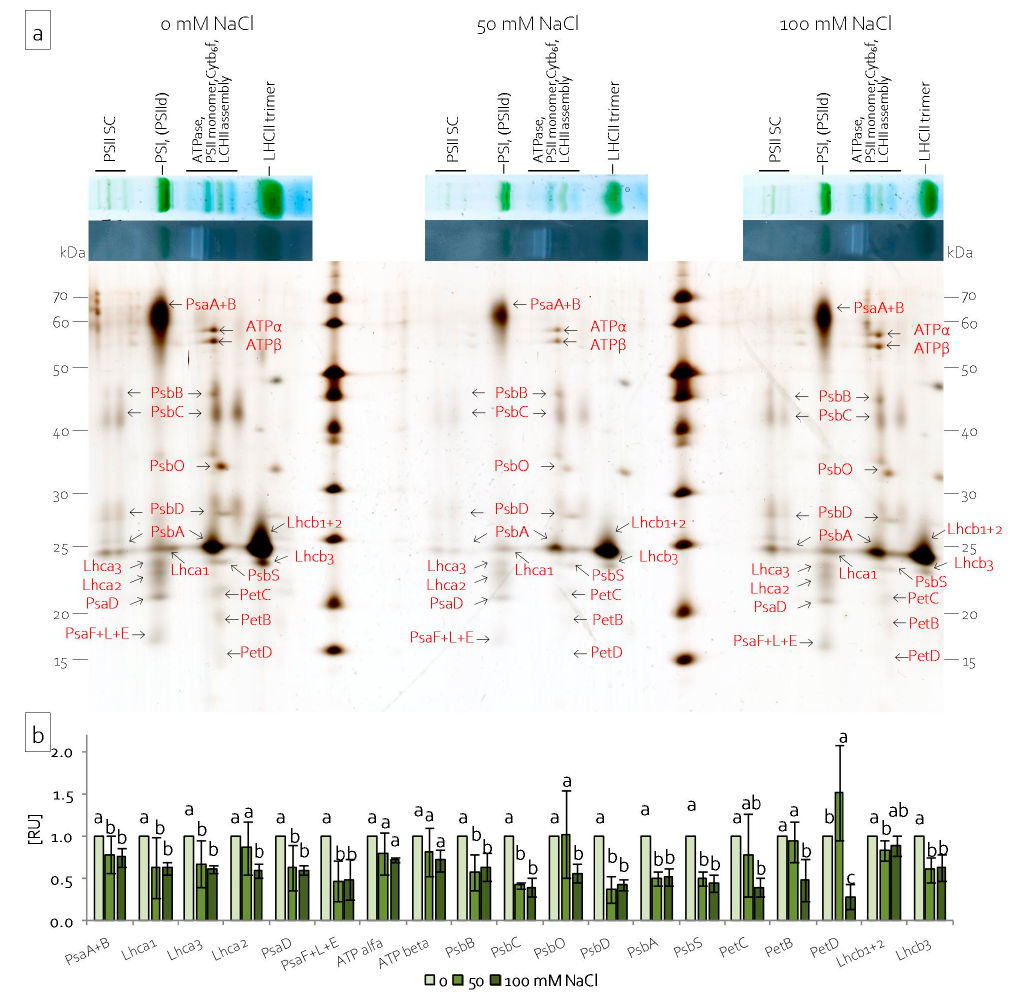
Figure 8. Protein composition of grass pea leaf chloroplasts under salinity; ( a ) two-dimensional protein patterns; ( b ) con- tent of particular proteins; content of proteins expressed as relative units [RU]; different letters—statistically significant differences within each protein at p ≤ 0.05; ( n = 3).